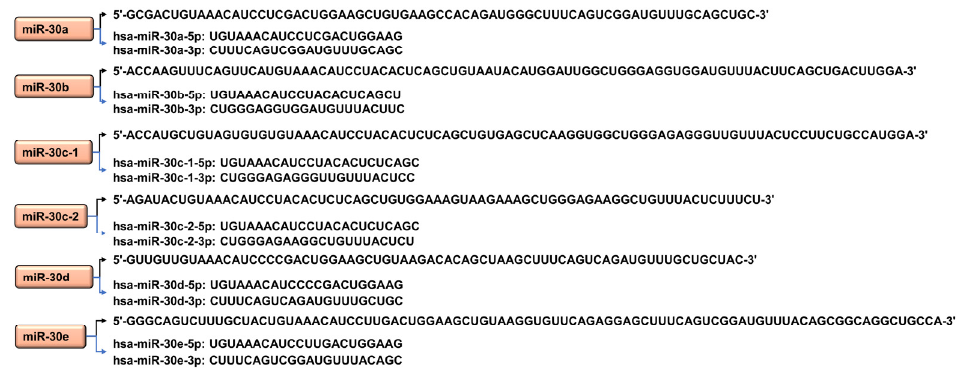
Figure 1. Biogenesis of miR-30 family. Ago: argonaute, Chro: chromosome, DBR1: lariat debranching enzyme, DGCR8: DiGeorge syndrome critical region gene 8, RISC: RNA-induced silencing complex, TRBP: transactivation response element RNA-binding protein.